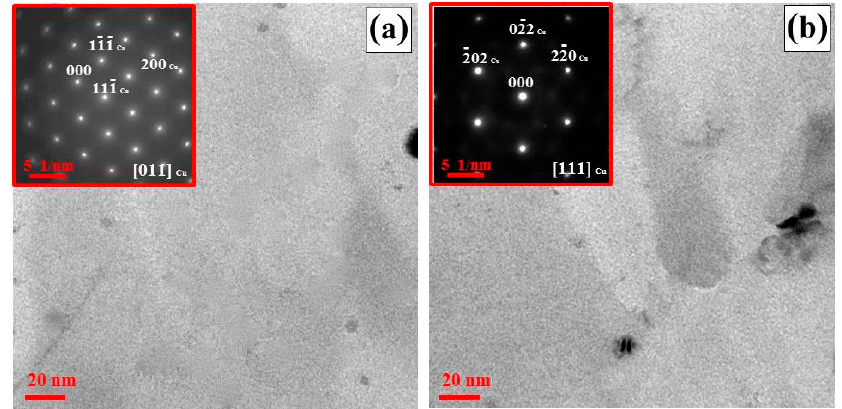
Figure 8. The bright-field TEM micrographs of samples from the CuCrZr-NZ and CuNiCrSi-NZ when the rotational speed increased to 1700 rpm (condition A7). ( a ) CuCrZr-NZ in the [011] Cu direction; ( b ) CuNiCrSi-NZ in the [111] Cu direction.